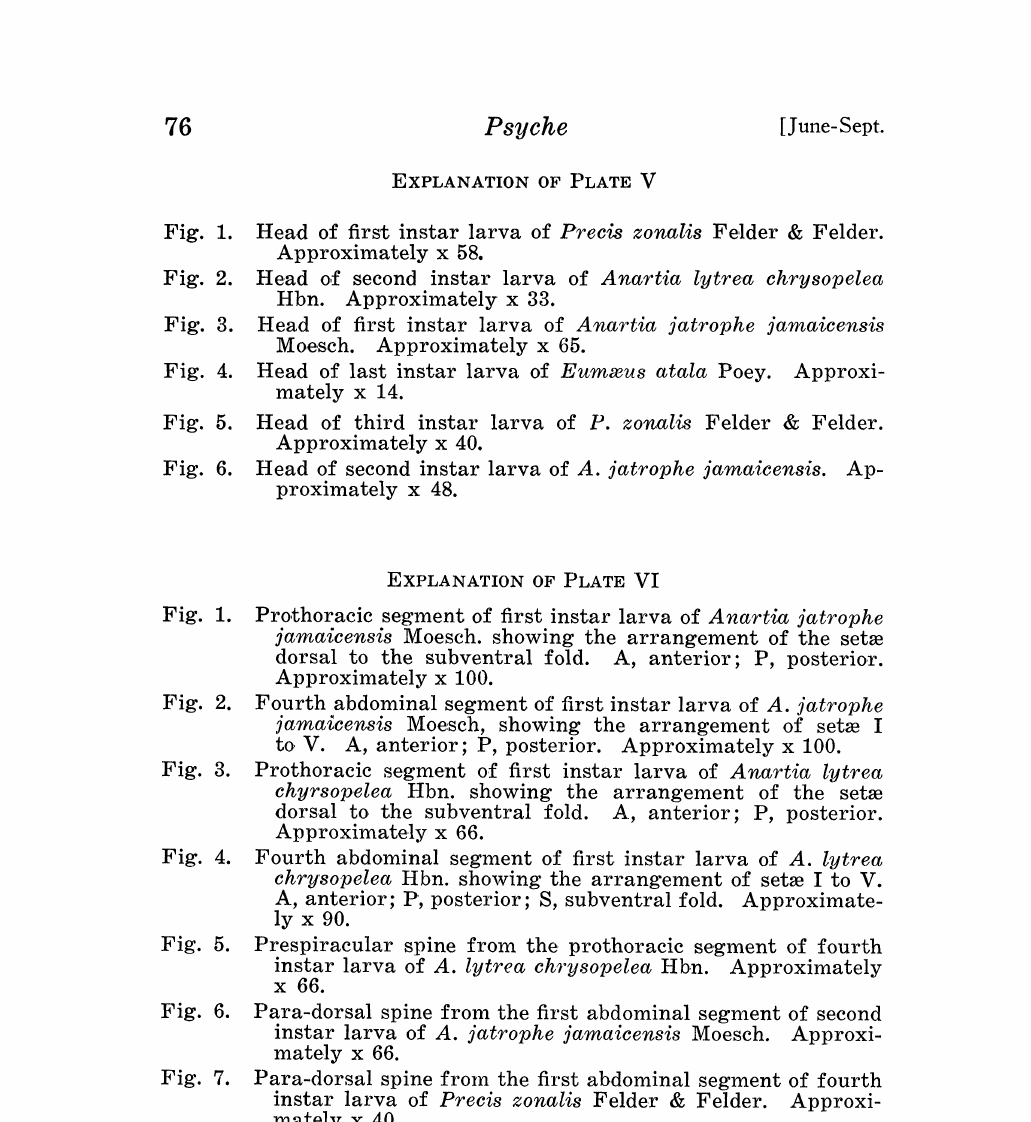
Fig. 1. Pro.thoracic segment of first instar larva of A nartia jatrophe ]amaicensis Moesch. showing the arrangement of the serge dorsal to the subventral fold. A, anterior; P, posterior. Approximately x 100. Fig. 2. Fourth abdominal segment of first instar larva of A. ]atrophe jamaicensis Moesch, showing the arrangement of setm I to. V. A, anterior; P, posterior. Approximately x 100. Fig. 3. Prothoracic segment o.f first instar larva of Anartia lytrea chyrsopelea Hbn. showing the arrangement of the setm dorsal to. the subventral fold. A, anterior; P, posterior. Approximately x 66. Fig. 4. Fourth abdominal segment of first instar larva of A. lytrea chrysopelea Hbn. showing the arrangement of setm I t.o V. A, anterior; P, posterior; S, subventral fold. Approximate- ly x 90. Fig. 5. Prespiracular spine from the. prothoracic segment of fourth instar larva of A. lytrea chrysopelea Hbn. Approximately x 66. Fig. 6. Para-dorsal spine from the first abdominal segment of second instar larva of A. ]atrophe jamaicensis Moesch. Approxi- mately x 66. Fig. 7. Para-dorsal spine frown the first abdominal segment of fourth instar larva of Precis zonalis Felder & Felder. Approxi- mately x 40. Fig. 8. Para-dorsal spine from the second thoracic segment of fourth instar larva of A. lytrea chrysopelea Hbn. Approximately x70. Fig. 9. Clypeus of last. instar larva o.f Eumaus atala Poey showing the arrangement of serge. Approximately x 30. Fig. 10. Same. Fig. 11. Spine from head of third instar larva of A. lytrea chrysopelea Hbn. Approximately x